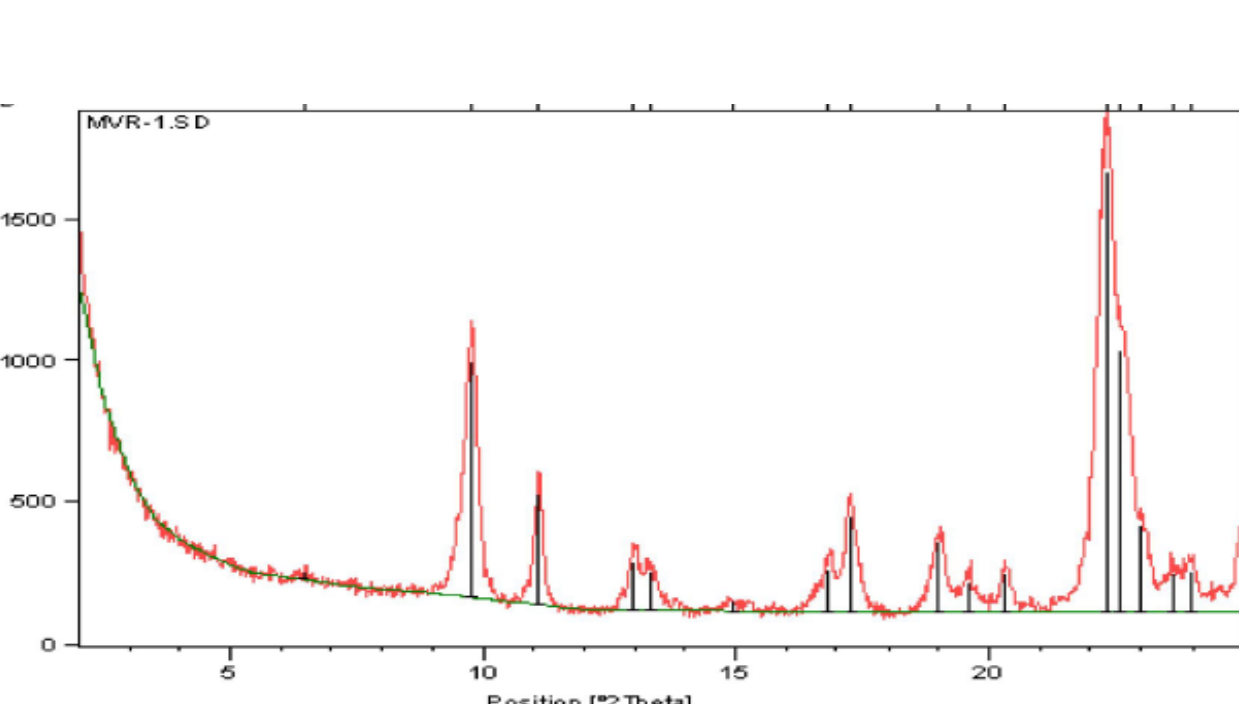
Fig. 7. XRD pattern of nanocomposite hydrogel containing 4 wt.% montmorillonite nanoclay cloisite